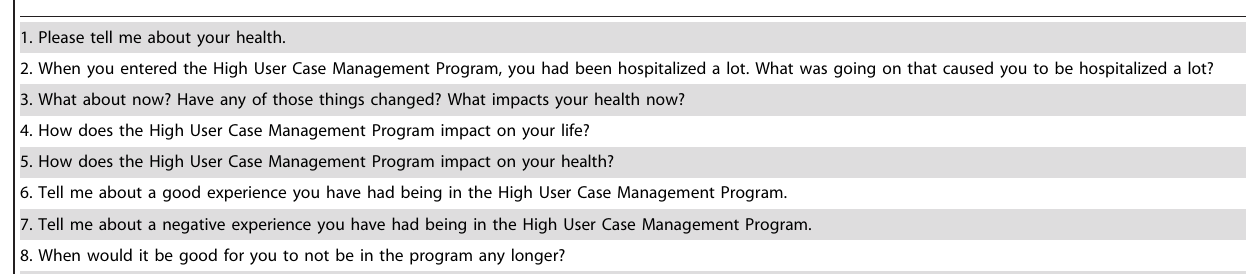
Table 1. Standard Interview Guide.